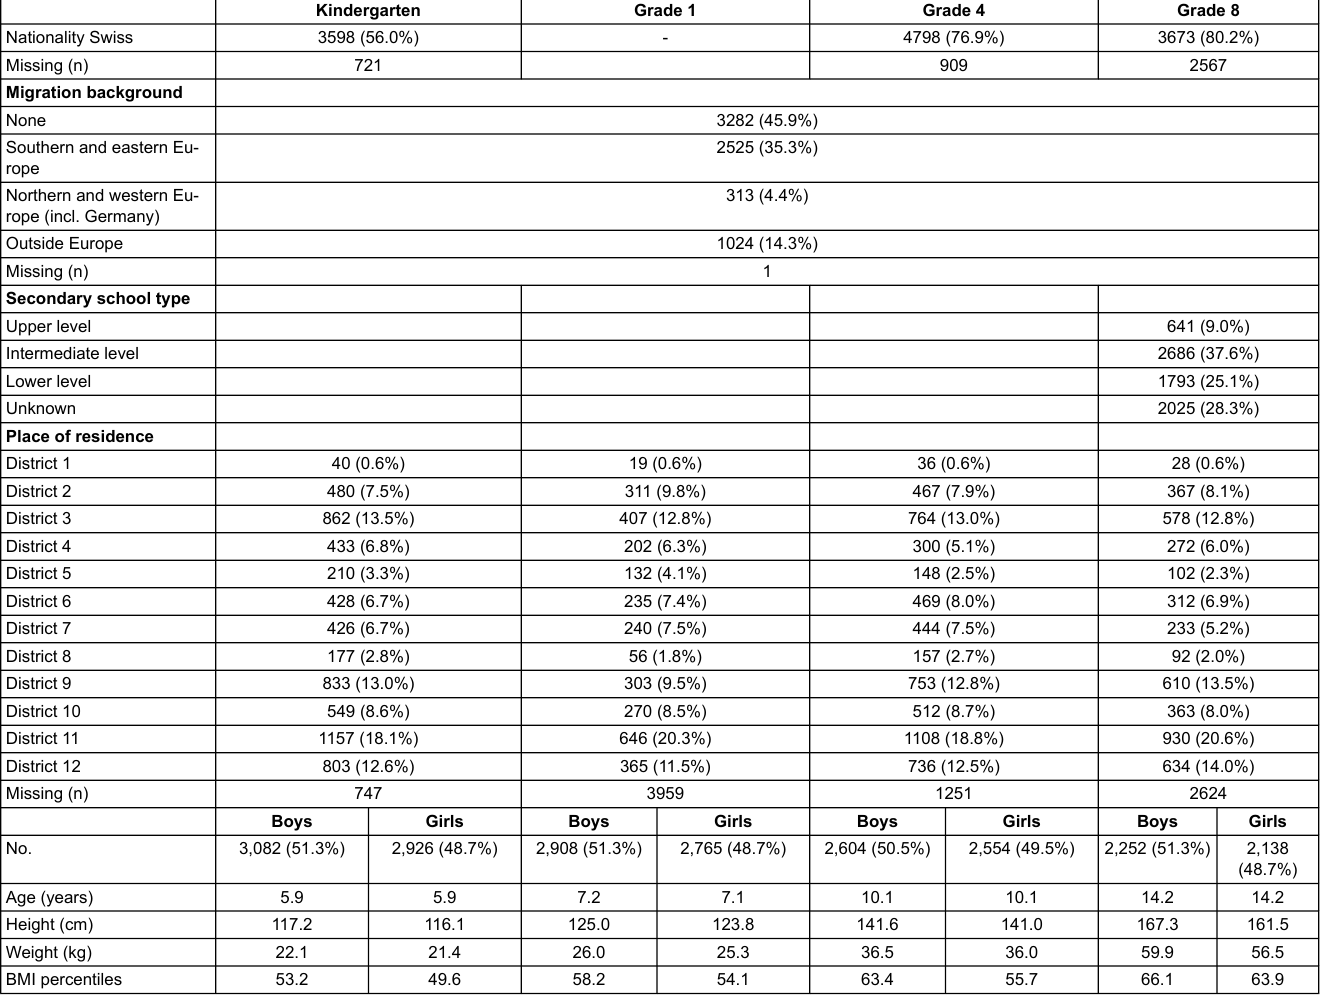
Table S2: Demographic characteristics of all children included in the study (n =